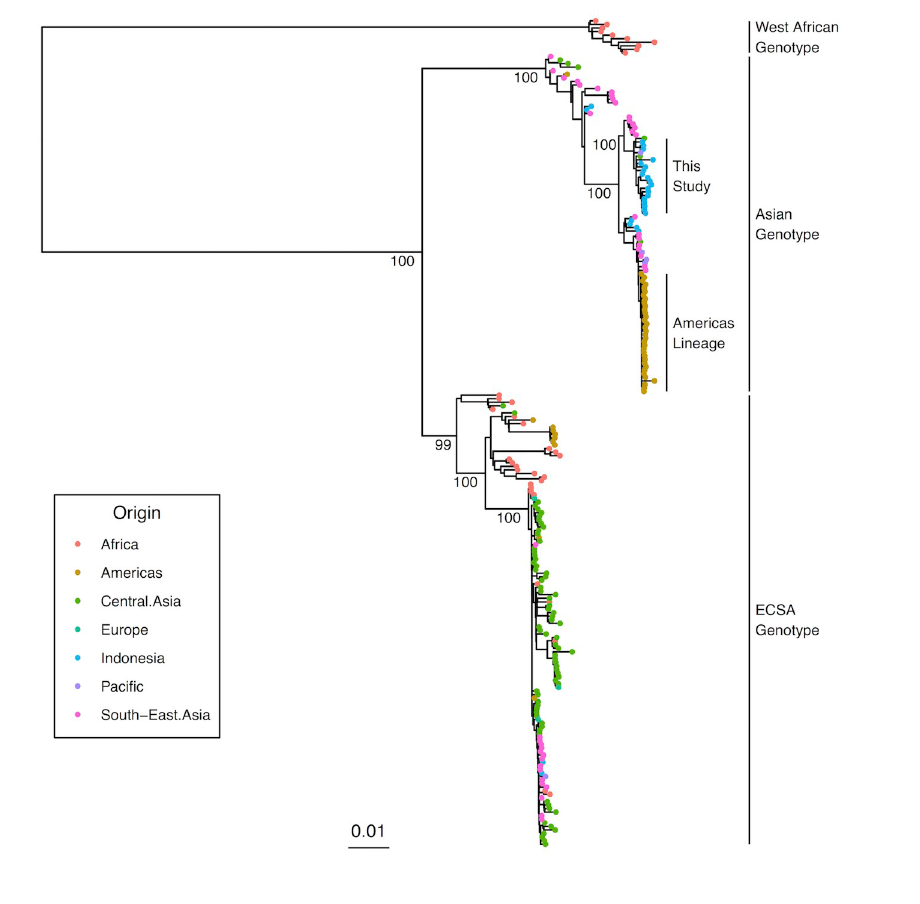
Fig 1. Maximum likelihood phylogeny generated from full-length coding region sequences of Chikungunya virus. Bootstrap branch support values are shown for major nodes of interest. Coloured tips denote each isolates’ region of